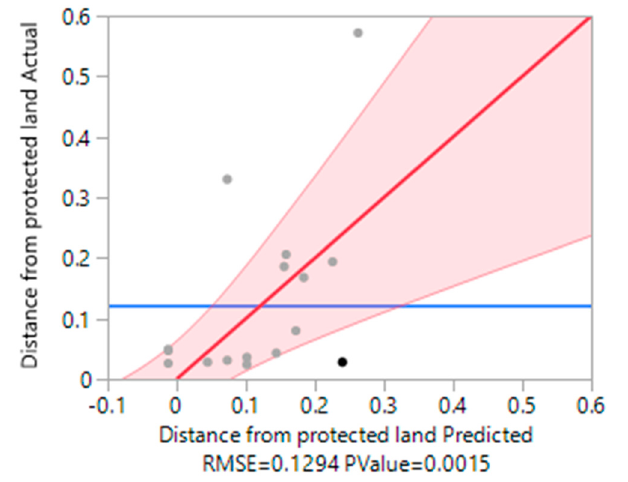
Figure 4. Actual by predicted plot—distance from protected land.